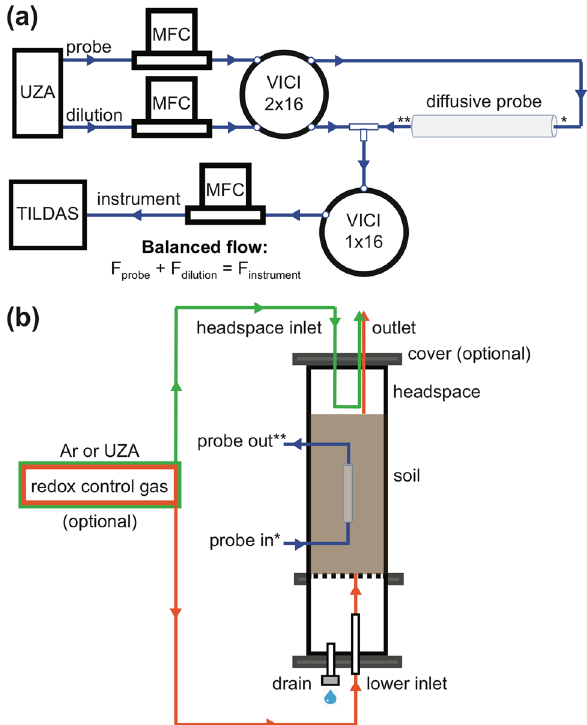
Figure 5. ( a ) Probes sample gases by diffusion across a sPTFE membrane into ultra zero air (UZA) flowing through the probe. Probe outflow is diluted. Flow is balanced—mass flow controllers (MFCs) control flow into the instrument at a rate equal to the sum of probe and dilution flows—to prevent advective flow across the membrane. Two VICI valves select the probe to sample (one of sixteen possible probes illustrated in this setup). ( b ) Lab-based soil columns to demonstrate probe performance (asterisks cross-reference plumbing in ( a )). Columns allowed wetting from above and drainage of excess water through sealable port at base. Redox state